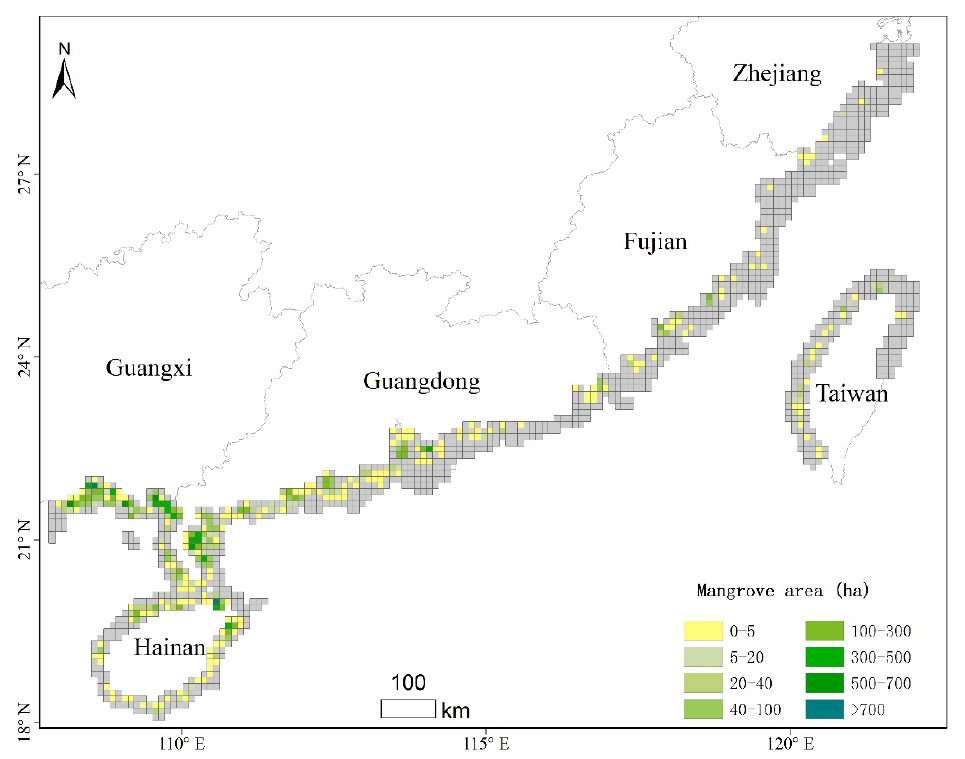
Figure 5. The spatial distribution of mangrove forests in China at a common unit of 0.1°. The grey color represents a 10 km buffer zone along the coastline.